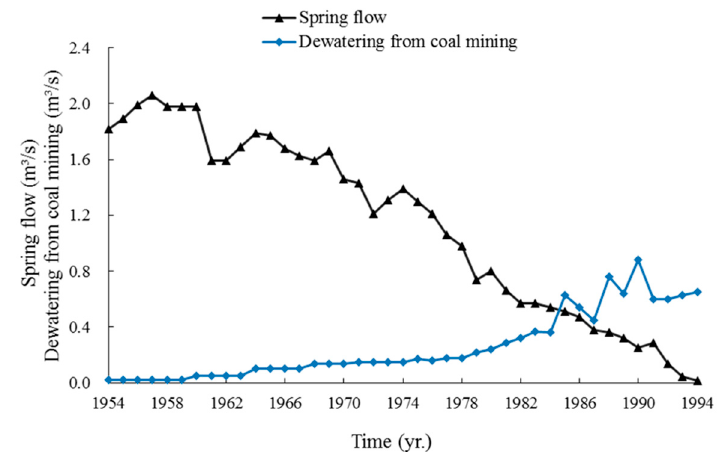
Figure 6. Spring flow and dewatering from coal mining in the Jinci Springs catchment.